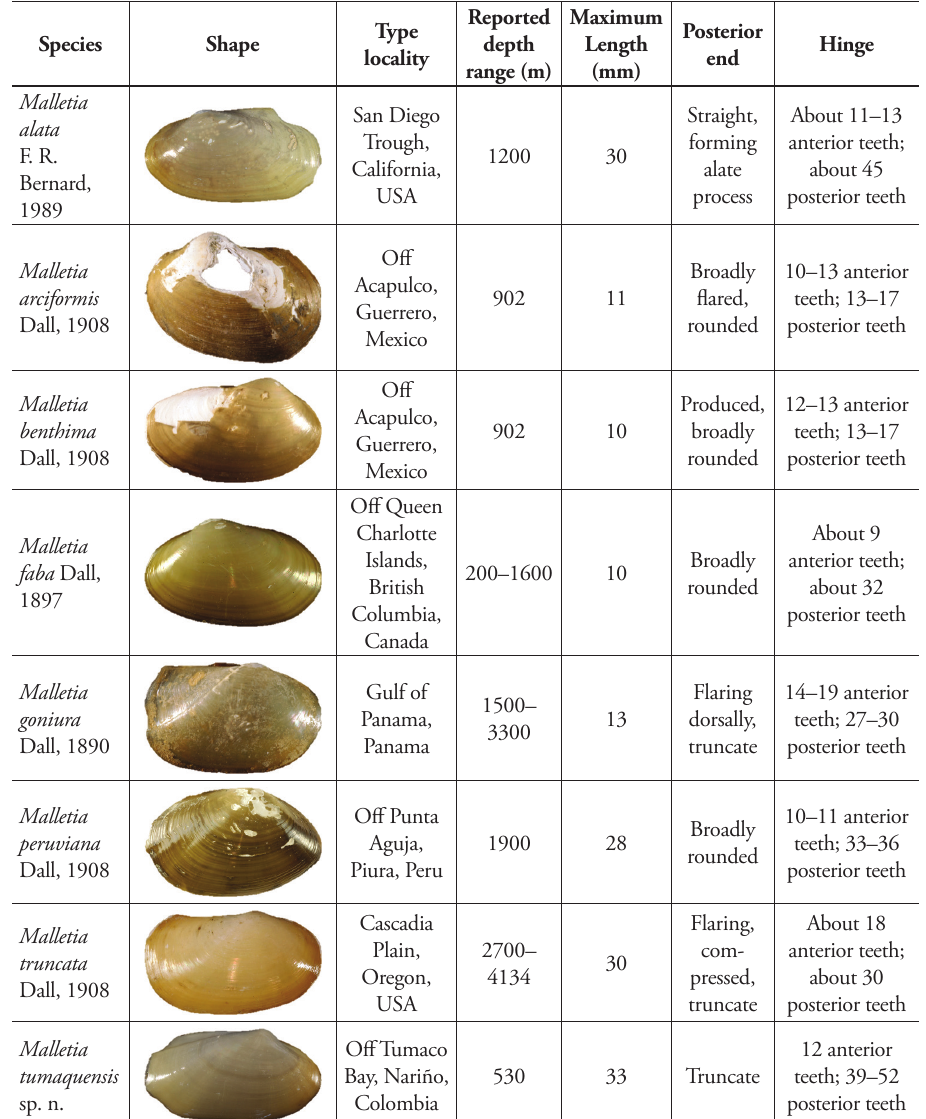
Table 3. Summary of shell characters of Malletia species from the Pacific Ocean (after Coan and Valen- tich-Scott